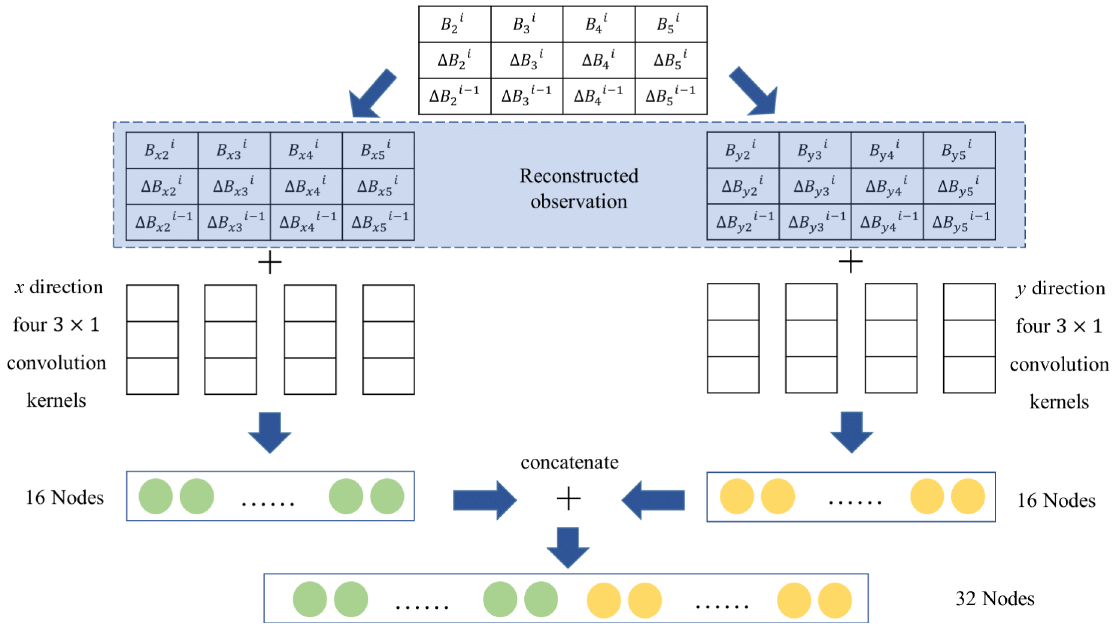
FIG. 4. The convolutional layer between the input layer and the first hidden layer. With four 3 × 1 convolution kernels for both x and y directions, the output of each direction is a 16-dimensional vector; then join the two vectors directly as the input of the next hidden